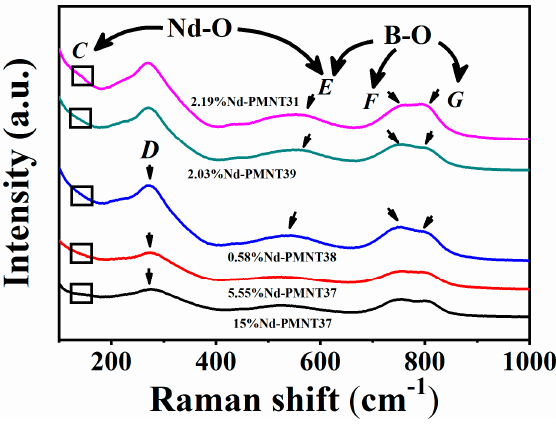
Figure 7. Raman scattering spectra of Nd-PMNT single crystals.